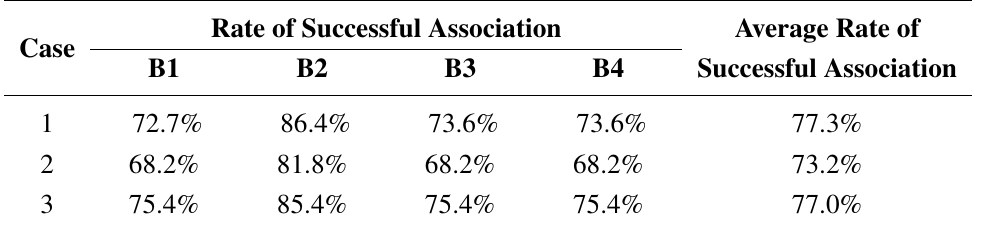
Table 5. Rate of associating correct correspondence for each beacon range measurement.